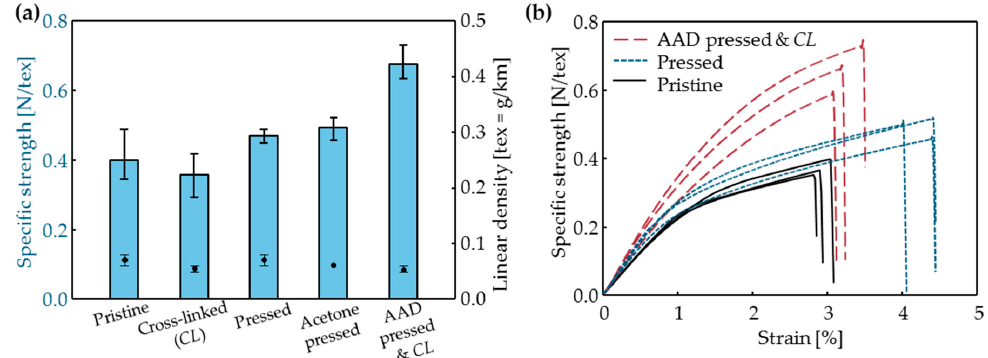
Figure 6. ( a ) The specific strength (bars) and linear density (circles) Error bars: minimum to maximum; and ( b ) Representative stress-strain curve of CNTFs. Table 3. The average ± s.d. (6 ≤ n ≤ 8) mechanical properties of CNTFs.